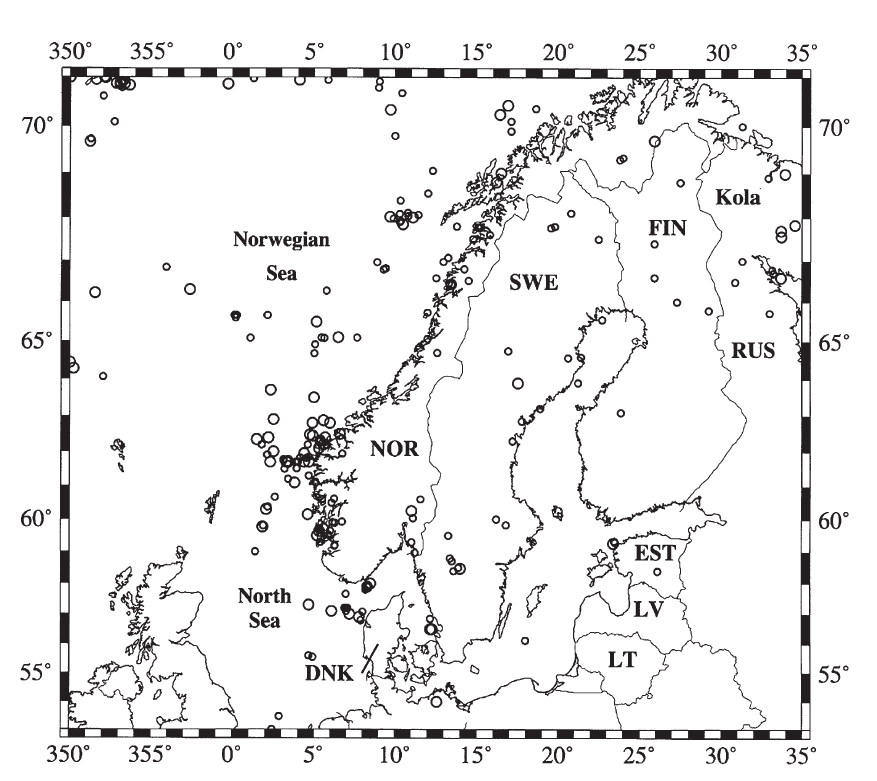
Fig. 1b. Region addressed in the present study. Letters denote present-day Denmark, Estonia, Finland, Latvia (LV), Lithuania (LT), Norway, Russia and Sweden. Circles show epicentres for earthquakes occurring between 1965 and 2002. The smaller symbols refer to magnitudes in the range of 3.5-3.9 and the larger symbols to mag- nitudes 4 or above as given in the FENCAT catalogue (Ahjos and Uski, 1992) and its updated version